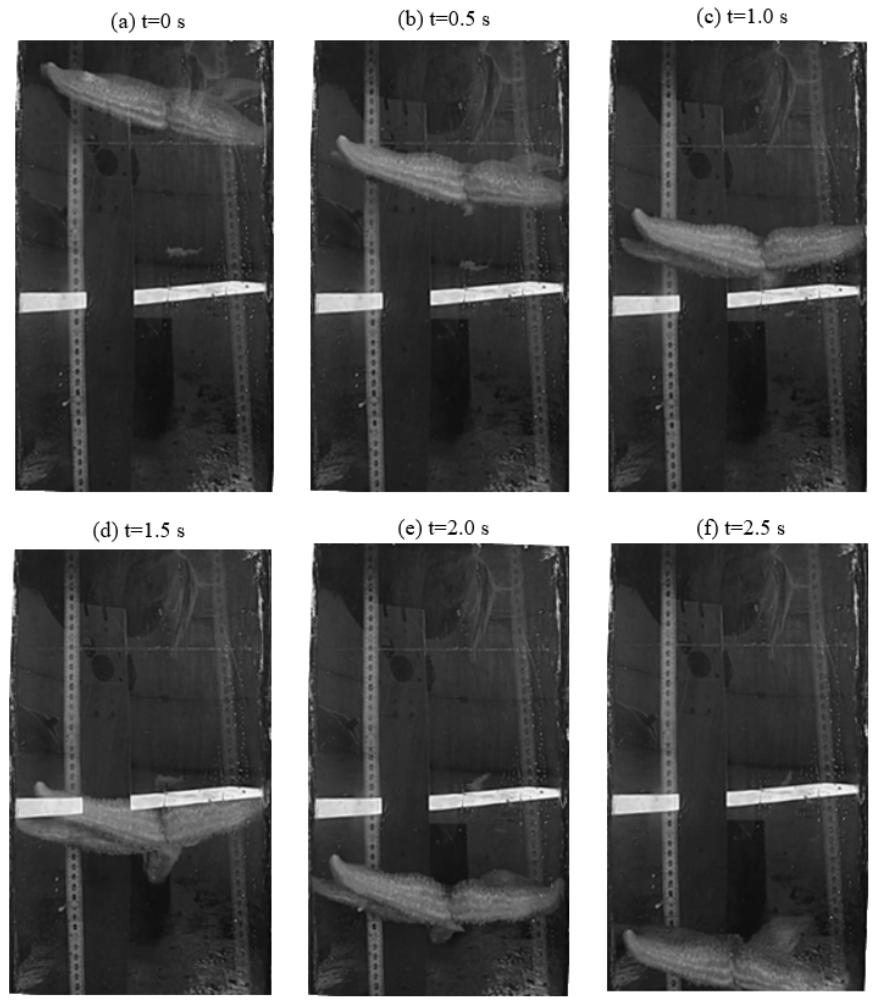
Figure 11. Snapshots of a sea star falling through water column in the settling velocity